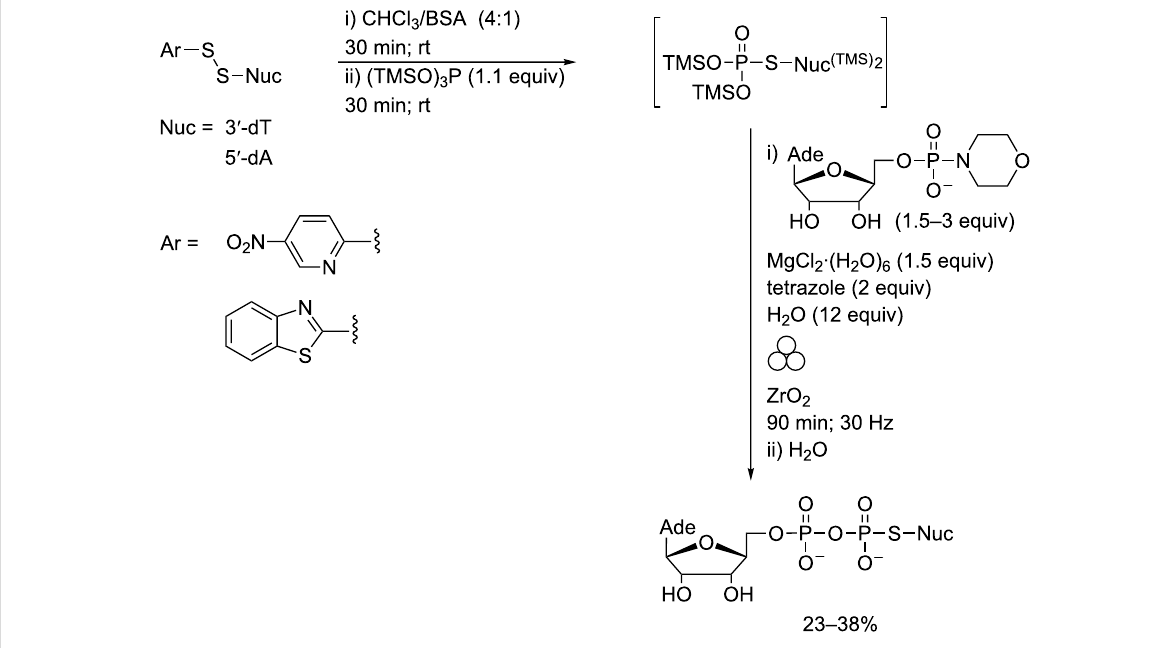
Miescher reported grinding the solid residues from defatted salmon sperm heads with dilute HCl (0.5%) to effect such